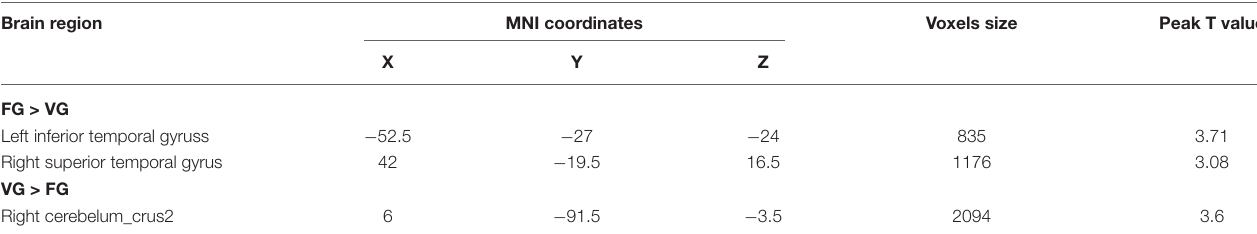
TABLE 2 | Brain regions showing significant difference in GMV by comparison of VG vs.